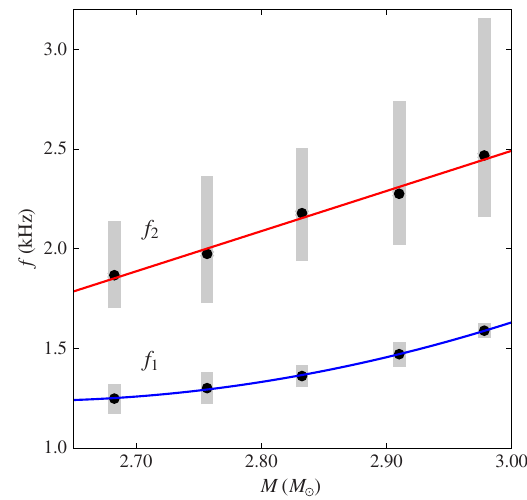
FIG. 3. Measured best-fit values of f 1 and f 2 versus the total system mass (solid black circles). The vertical gray bars on the lower-frequency spectral feature represent the standard deviation of the Gaussian fit at each mass value (not the measurement uncertainty). The corresponding bars on the higher-frequency data represent the total frequency span of the feature. The blue curves and the red curves show the least-squares fit to f 1 and f 2 for a second- and first-order polynomial, respectively [given in Eq.